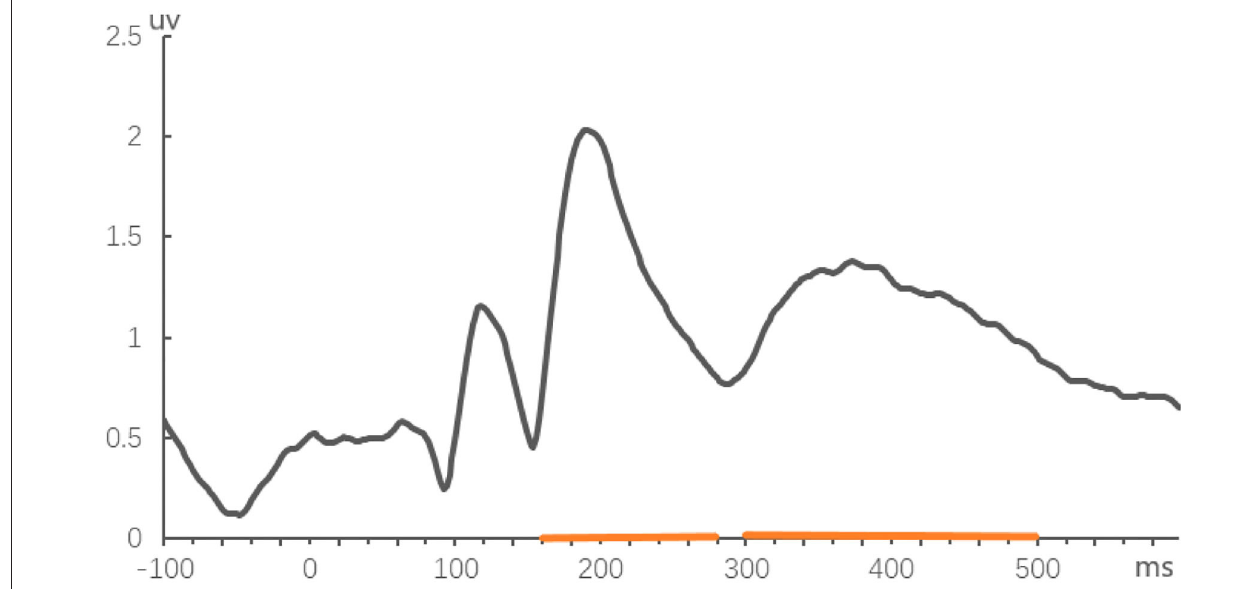
FIGURE 1 | Global field power averaged across all experimental conditions and across 24 subjects.